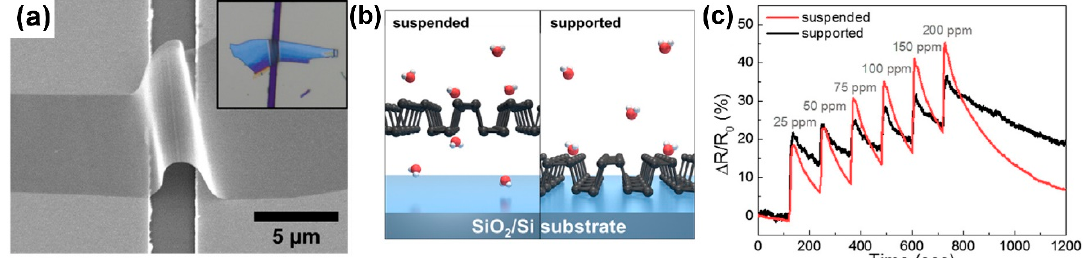
Figure 22. Panel ( a ): SEM image of the suspended phosphorene flake. Inset: optical image of the suspended flake; Panel ( b ): schematic illustration of the target gas molecules adsorbing on the suspended and supported phosphorene flake; Panel ( c ): responses of the suspended and the supported phosphorene flakes to increasing NO 2 concentrations (from 25 to 200 ppm). (Adapted and reprinted from [211], with permission from Elsevier, Amsterdam, The Netherlands).